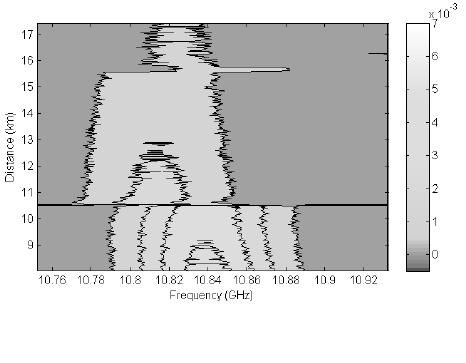
Figure 11. Brillouin gain spectra along the sensing channel focused on the 5 km section with 180 m heated to 60